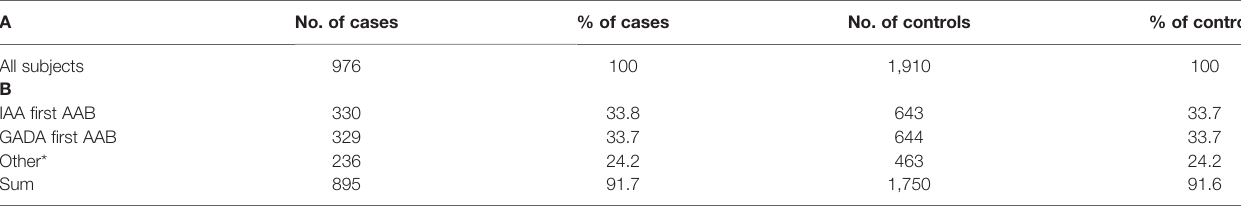
TABLE 1 | Number of AAB positive cases and their matched controls in complete cohort (A) and endotype speci fi c subgroups (B)